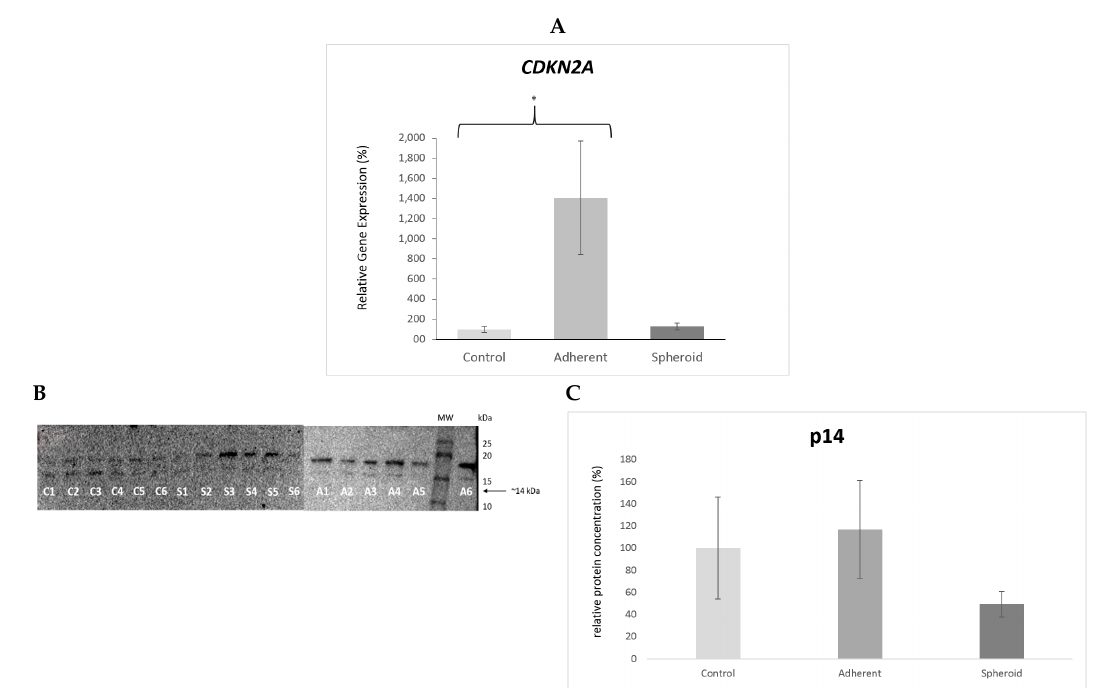
7 Figure 6. ( A ) CDKN2A g ene expression was significantly upregulated (14.1×, * p < 0.05) in the adherent cells under simulated microgravity. There was no significant change in gene expression (1.3×) in the spheroids. ( B ) Western blot bands showing P14 protein production (molecular